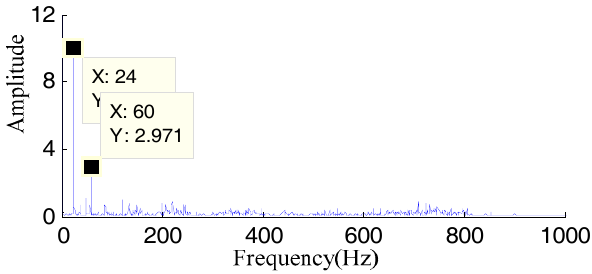
Figure 11. Details of Figure 9b from zooming out of the display range.